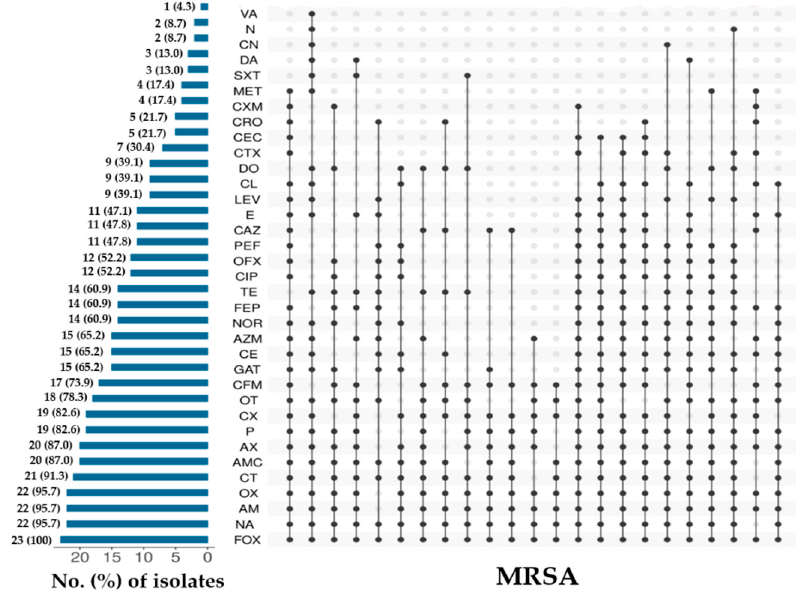
Figure 3. Individual antimicrobial resistance pattern of methicillin-resistant S. aureus (MRSA) isolated from frozen chicken meat.